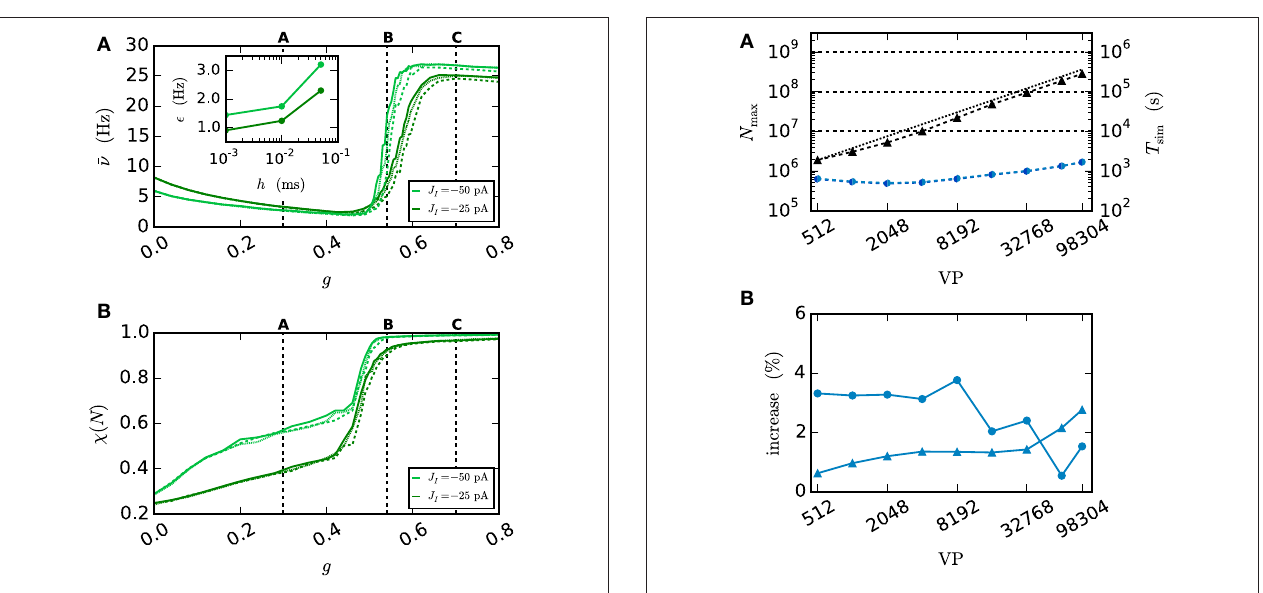
FIGURE 10 | Network behavior depending on the gap weight g . (A) The average spike rate ¯ ν and (B) the synchrony χ (Equation 10) of the neurons in the network, depending on the gap weight. The results for the iterative method with cubic interpolation are shown as solid curves (step size 0 . 05ms ) and for the single-step method with dashed (step size 0 . 05ms ) and dotted (step size 0 . 001ms ) curves. Two different synaptic amplitudes J I = − 50 pA and J I = − 25 pA were used, as indicated by the figure legend. The prelim_tol was chosen as 10 − 5 and the maximum number of iterations was not used as a stopping criterion. The simulation duration was 100 s ( J I = − 25 pA ), respectively 180 s ( J I = − 50 pA ) of biological time. The inset of (A) shows the difference between the results of the iterative method (step size 0 . 05ms ) and the results of the single-step method for different step sizes h measured by the RMSE. The dotted vertical lines correspond to the panels of Figure 9 .